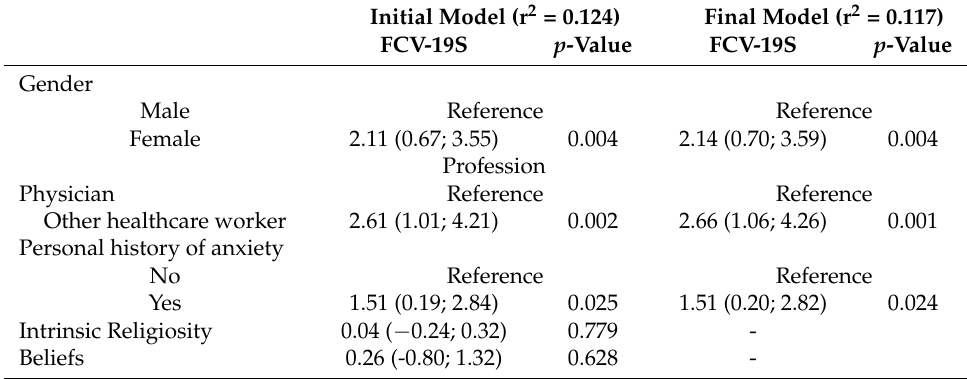
Table 4. Multivariable Model—Fear of COVID-19 Scale (FCV-19S). Initial Model (r 2 =